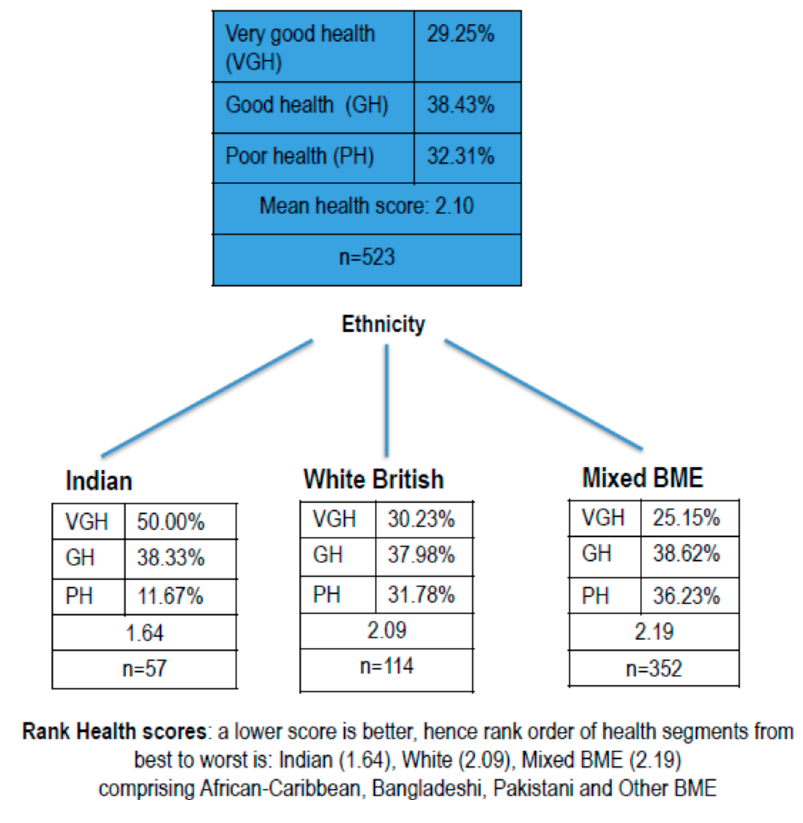
Figure 1. Chi-Squared Automatic Interaction Detection (CHAID) segmentation of data by general health. RQ2: how do ethnic groups differ in their perceptions of place characteristics? (Table 2) Between-group differences (Kruskal Wallis) in perceptions of neighbourhood environmental